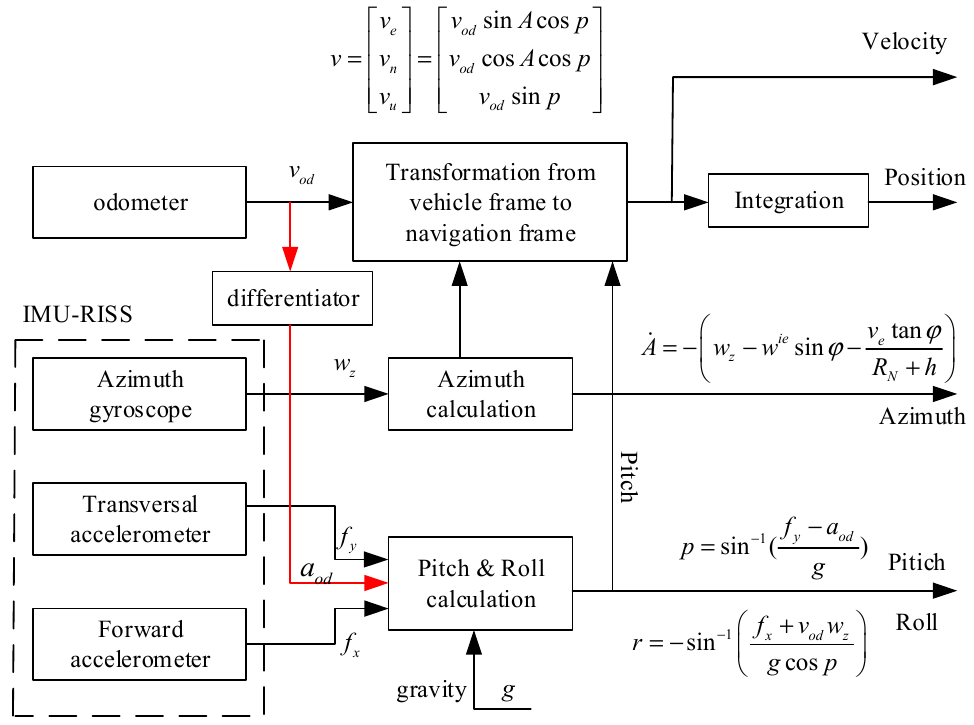
Figure 1. The schematic diagram of 3D RISS mechanization.